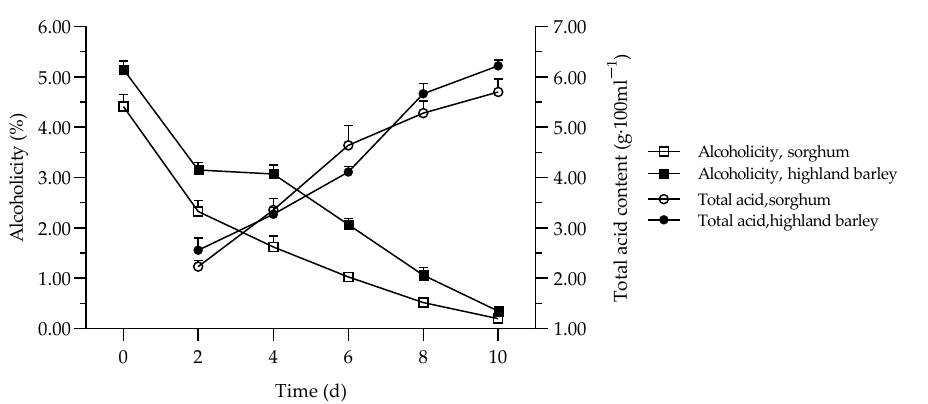
Figure 3. Changes of alcohol and TA concentrations during AAF.